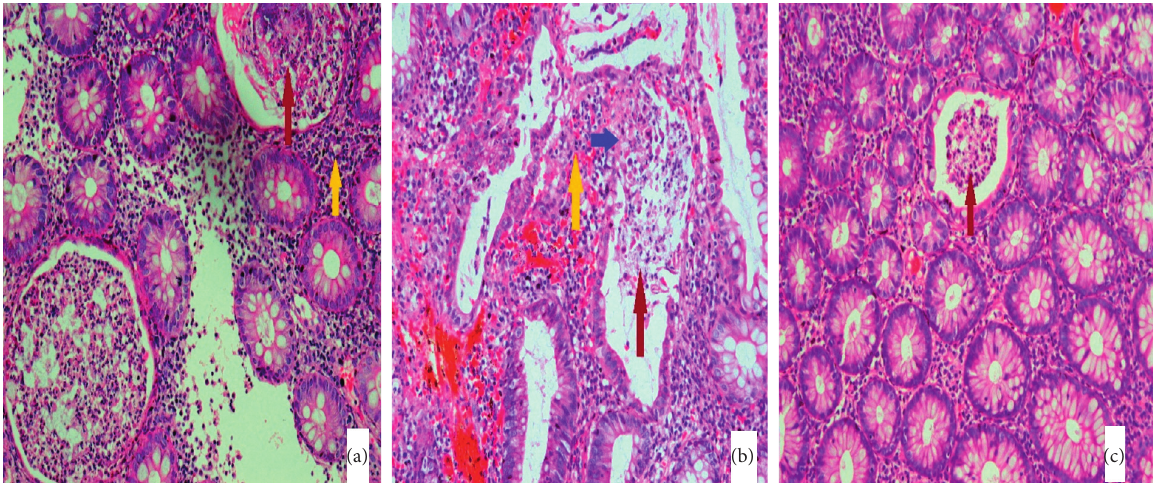
Figure 2: (40x): hematoxylin-and-eosin-stained light microscopic images (a–c). Evidence of crypt abscesses (maroon arrow), marked lymphocytic infiltration of the lamina propria (yellow arrow), and colonic mucosal ulceration with mucin depletion.